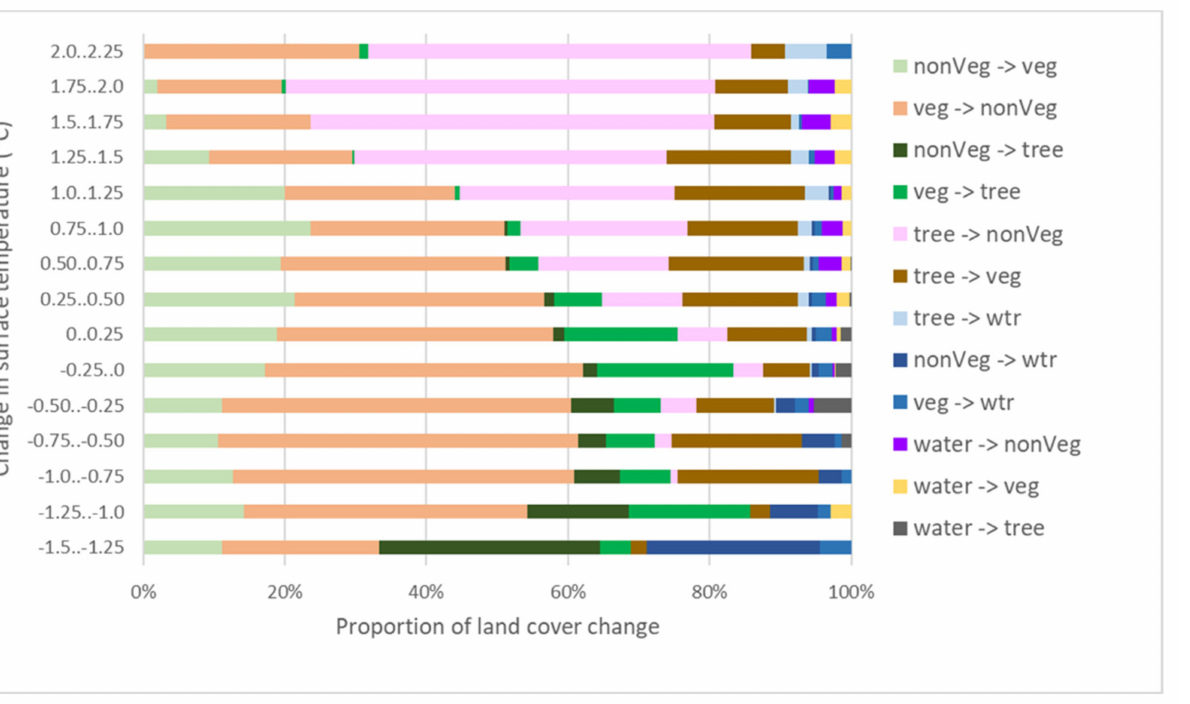
Figure 6. Proportion of land cover transition categories for surface temperature change classes between 2014 and